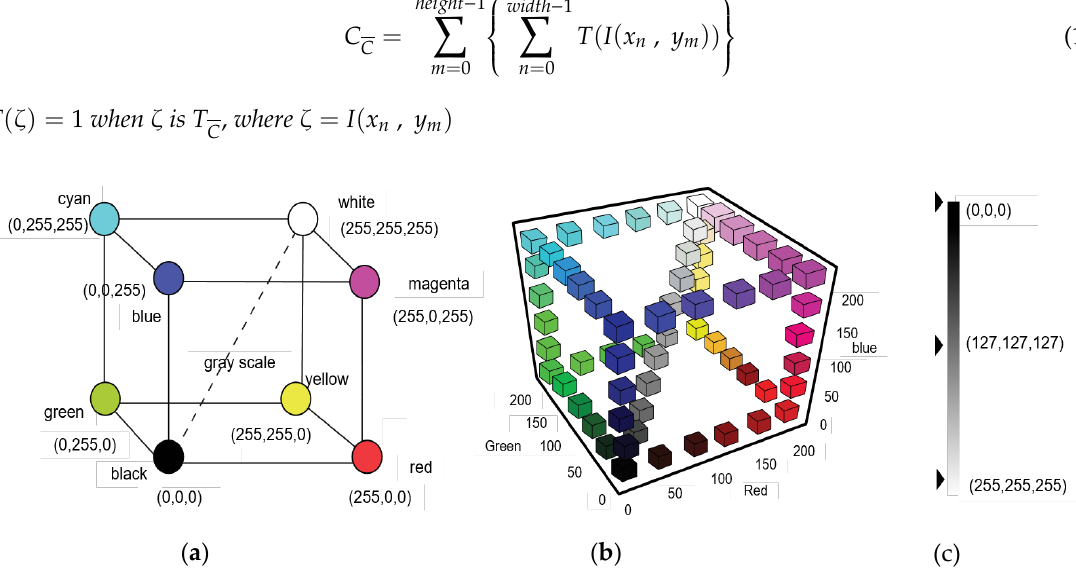
Figure 3. Visualization of RGB color space: (a) RGB-cube with 8 pure colors, (b) RGB–cube with colors distribution, and (c) gray shades distribution bar.